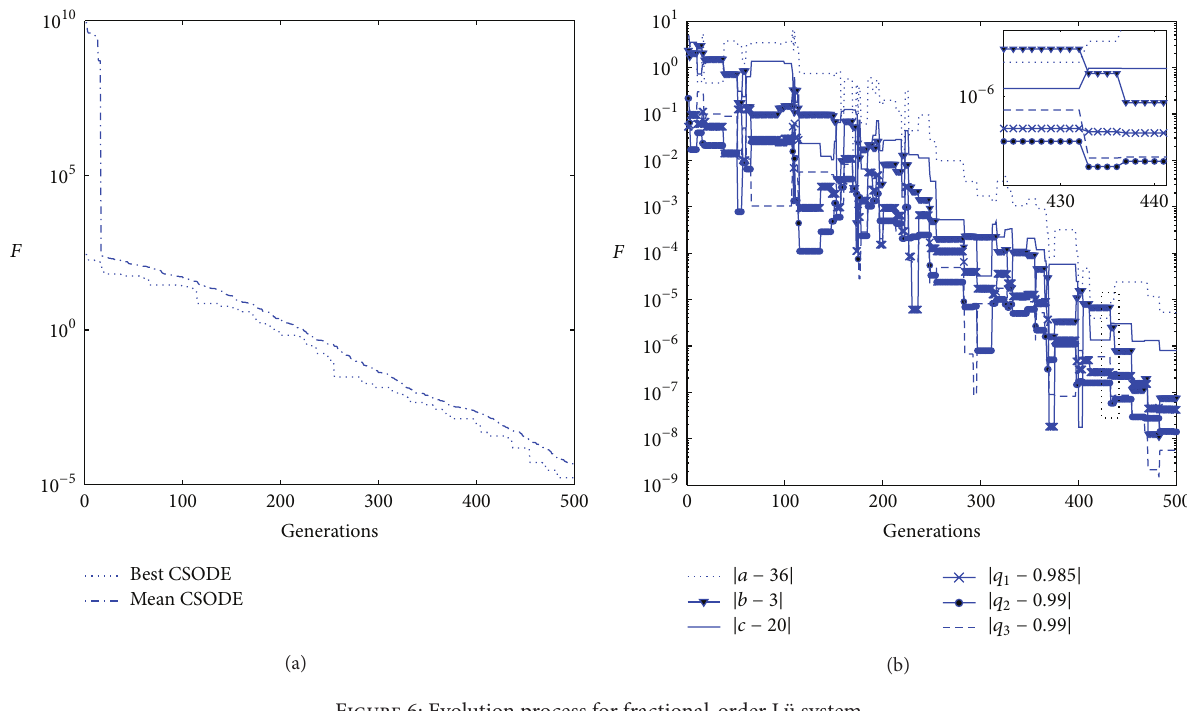
Figure 6: Evolution process for fractional-order L¨u system.